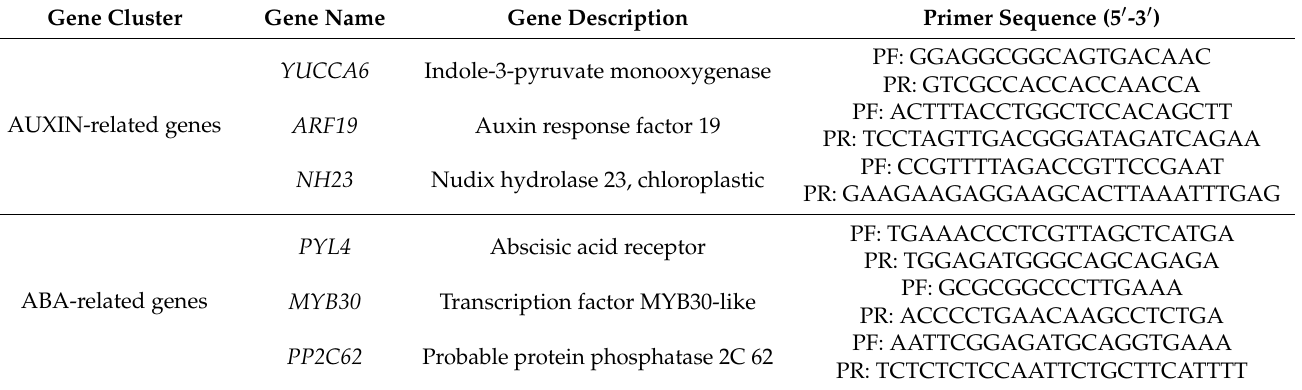
Table 3. Gene name and primer sequences of the genes selected for RT-qPCR validation. The six DEGs selected for validation are listed and divided according to the hormonal cluster they belong to. Each gene description is also provided. Primer forward (PF) and reverse (PR) are given for each